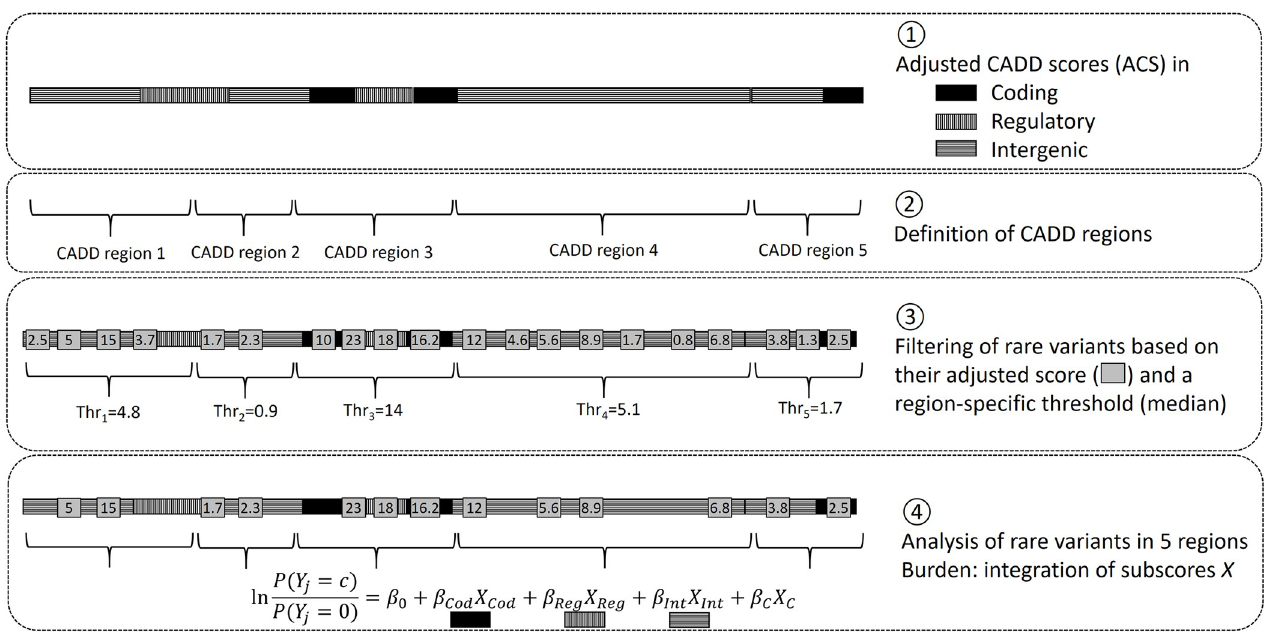
Fig 1. Steps performed in RAVA-FIRST: definition of ACS, CADD regions, region-specific thresholds and functionally-informed burden tests.